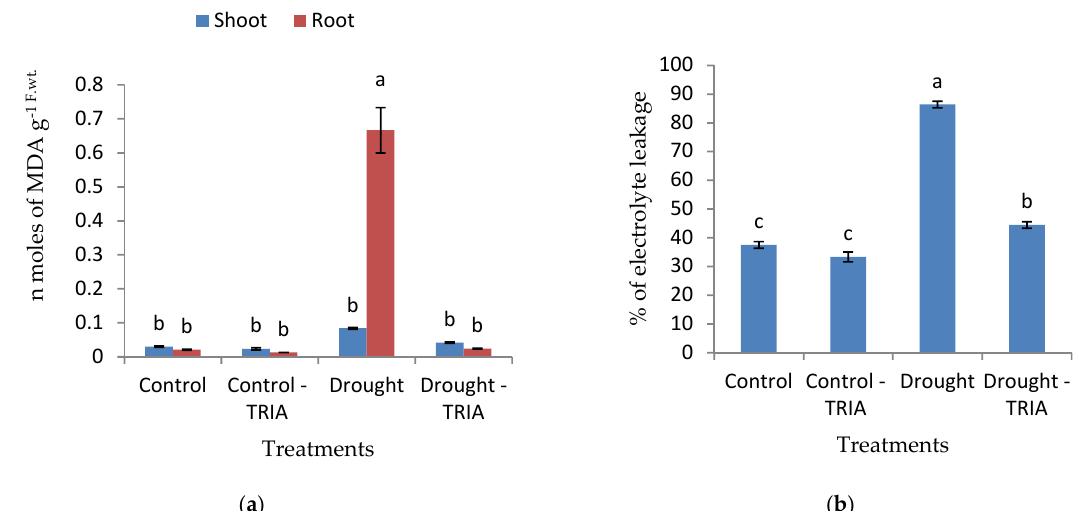
Figure 4. Effects of TRIA (35 ppm) treatment on ( a ) malondialdehyde (MDA) content and ( b ) the percentage of electrolytes leakage (EL) of drought-stressed rice seedlings. Each value is the mean of three replicates ± SE. Columns with different letters are significantly different at p ≤ 0.05.